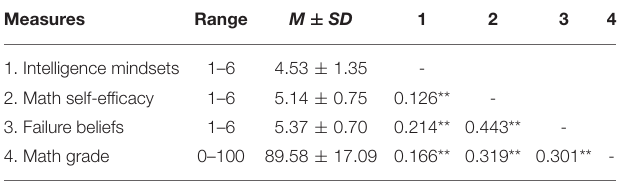
TABLE 1 | Descriptive analysis and intercorrelations.